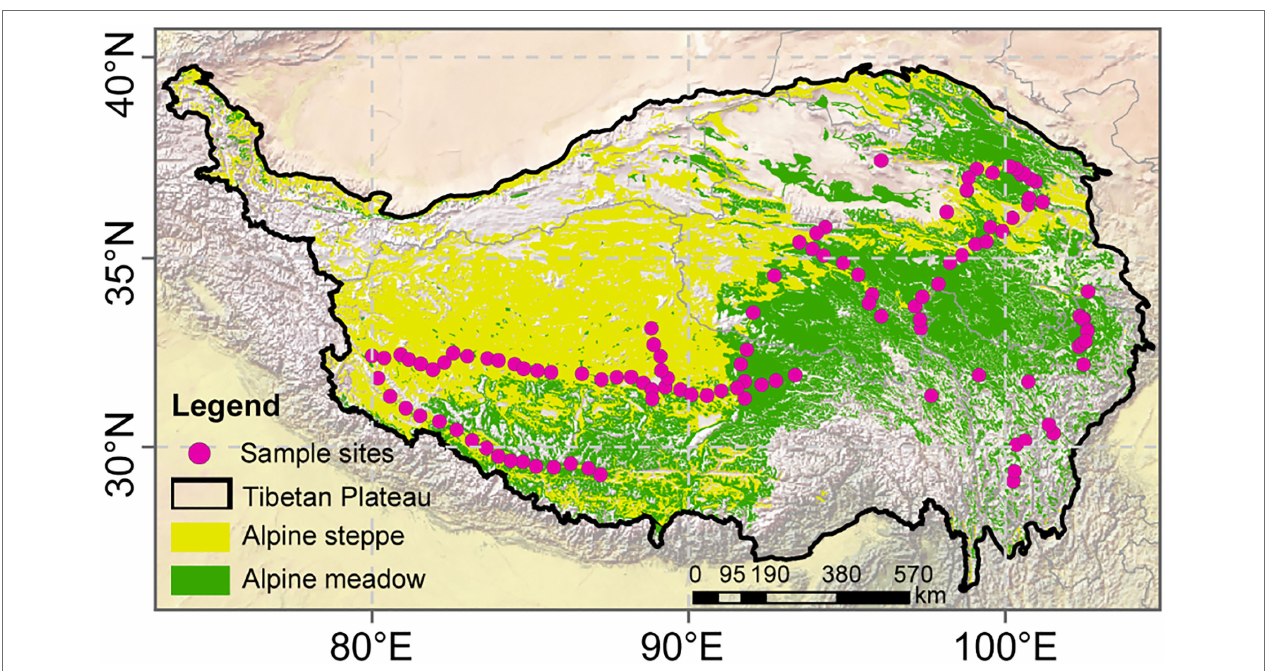
FIGURE 1 | Vegetation map of the Tibetan Plateau grasslands and location of sampling sites in